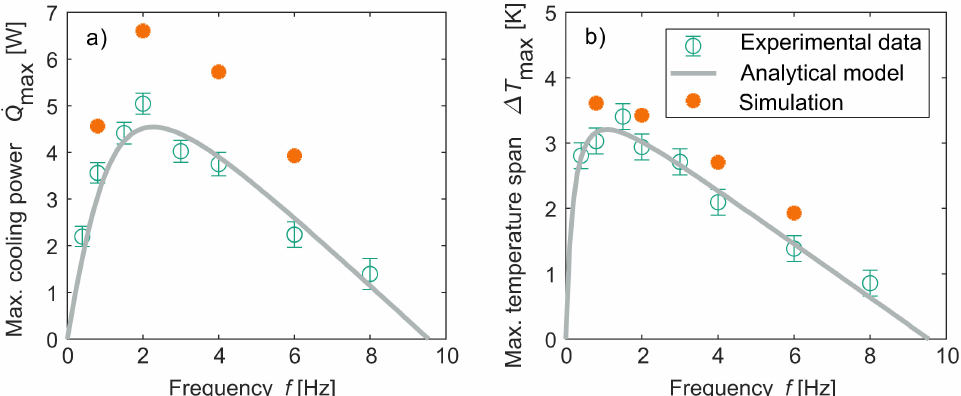
Figure 8. The analytical model and time dependent simulation of the measurement data pertaining to the maximum cooling power ( a ) and maximum temperature span ( b ). The simulation overestimated the measurement data, while the model depicts them